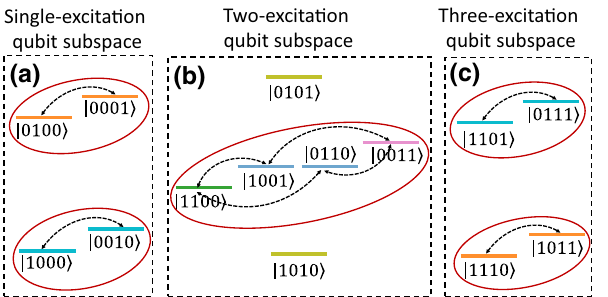
FIG. 11. Next-nearest-neighbor interaction in (a) single- excitation subspace, (b) two-excitation subspace, (c) three- excitation subspace. In the four-qubit system shown in Fig. 5, the typical detuning between next-nearest-neighbor qubits is 20 MHz. During the CZ gate operation, a flux pulse tunes the tun-